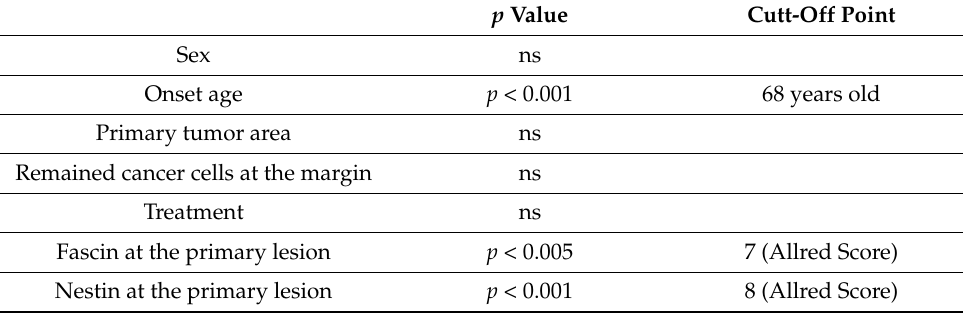
Table 3. Statistical results between each variable and